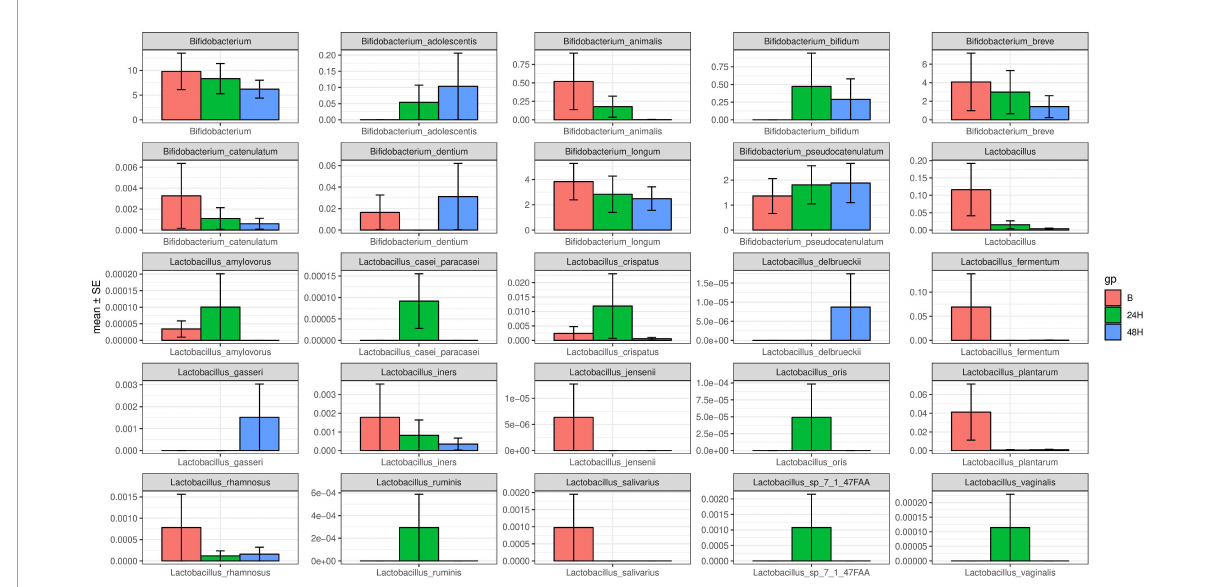
FIGURE2 Different Bifidobacterium and Lactobacillus strains change after 24 and 48 h of phototherapy.